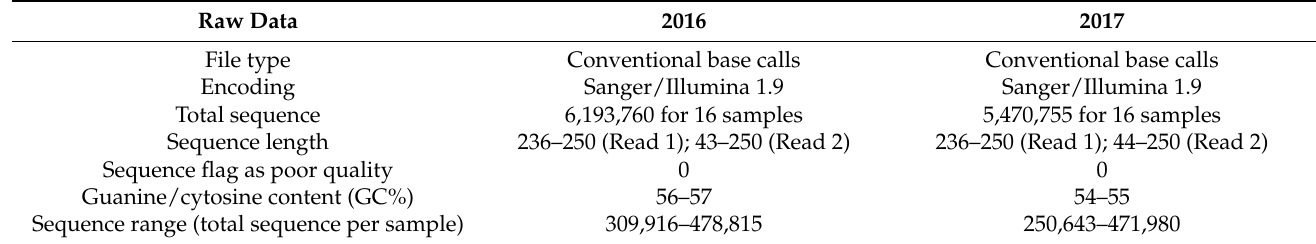
Table 2. Sequence statistics: FastQC data from the sequences in 2016 and 2017. Raw